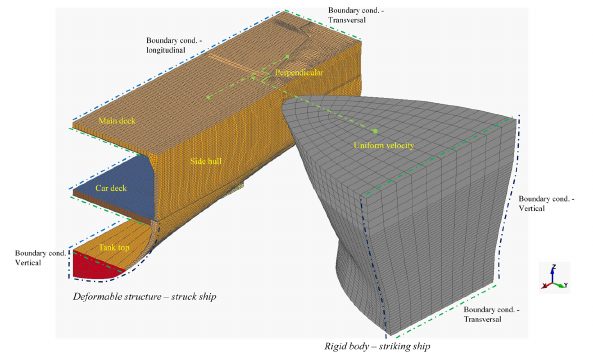
Figure 4: Configurations of the collision scenario for the FE